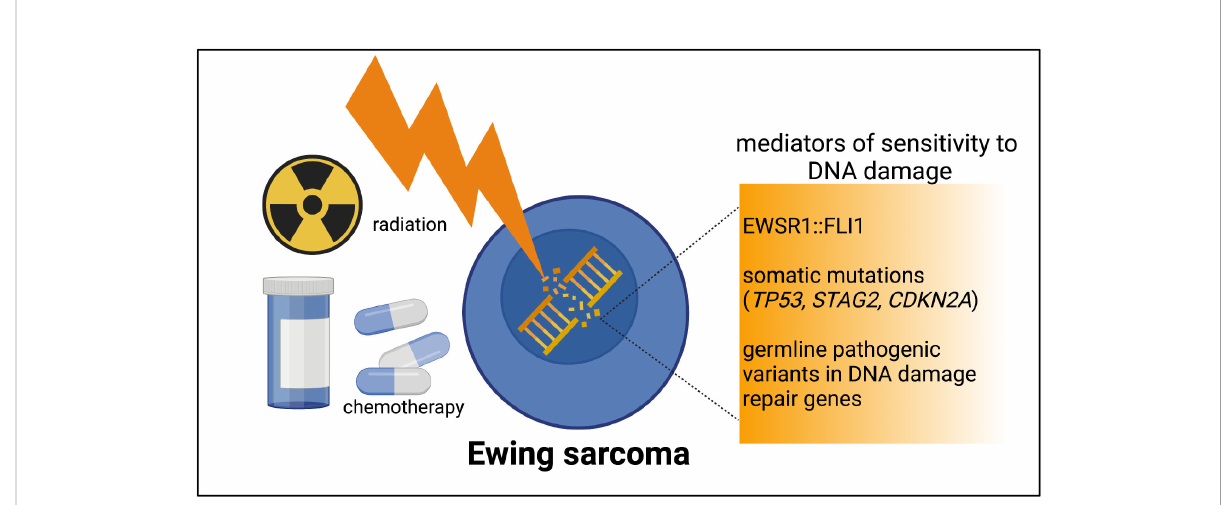
FIGURE 1 The spectrum of DNA damage repair de fi ciencies in Ewing tumors. Ewing tumors all have a level of DNA damage repair de fi ciency imparted by EWSR1::FLI1. The presence of one or more recurrent somatic mutations or rare germline pathogenic variants have the potential to contribute an additional level of DNA damage repair de fi ciency in a subset of Ewing tumors. Figure created by